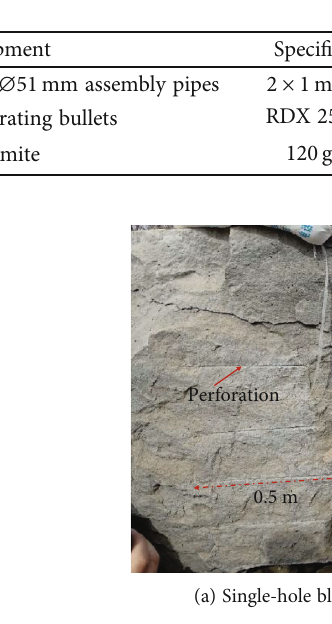
Figure 5: Ground test of compound perforating blasting